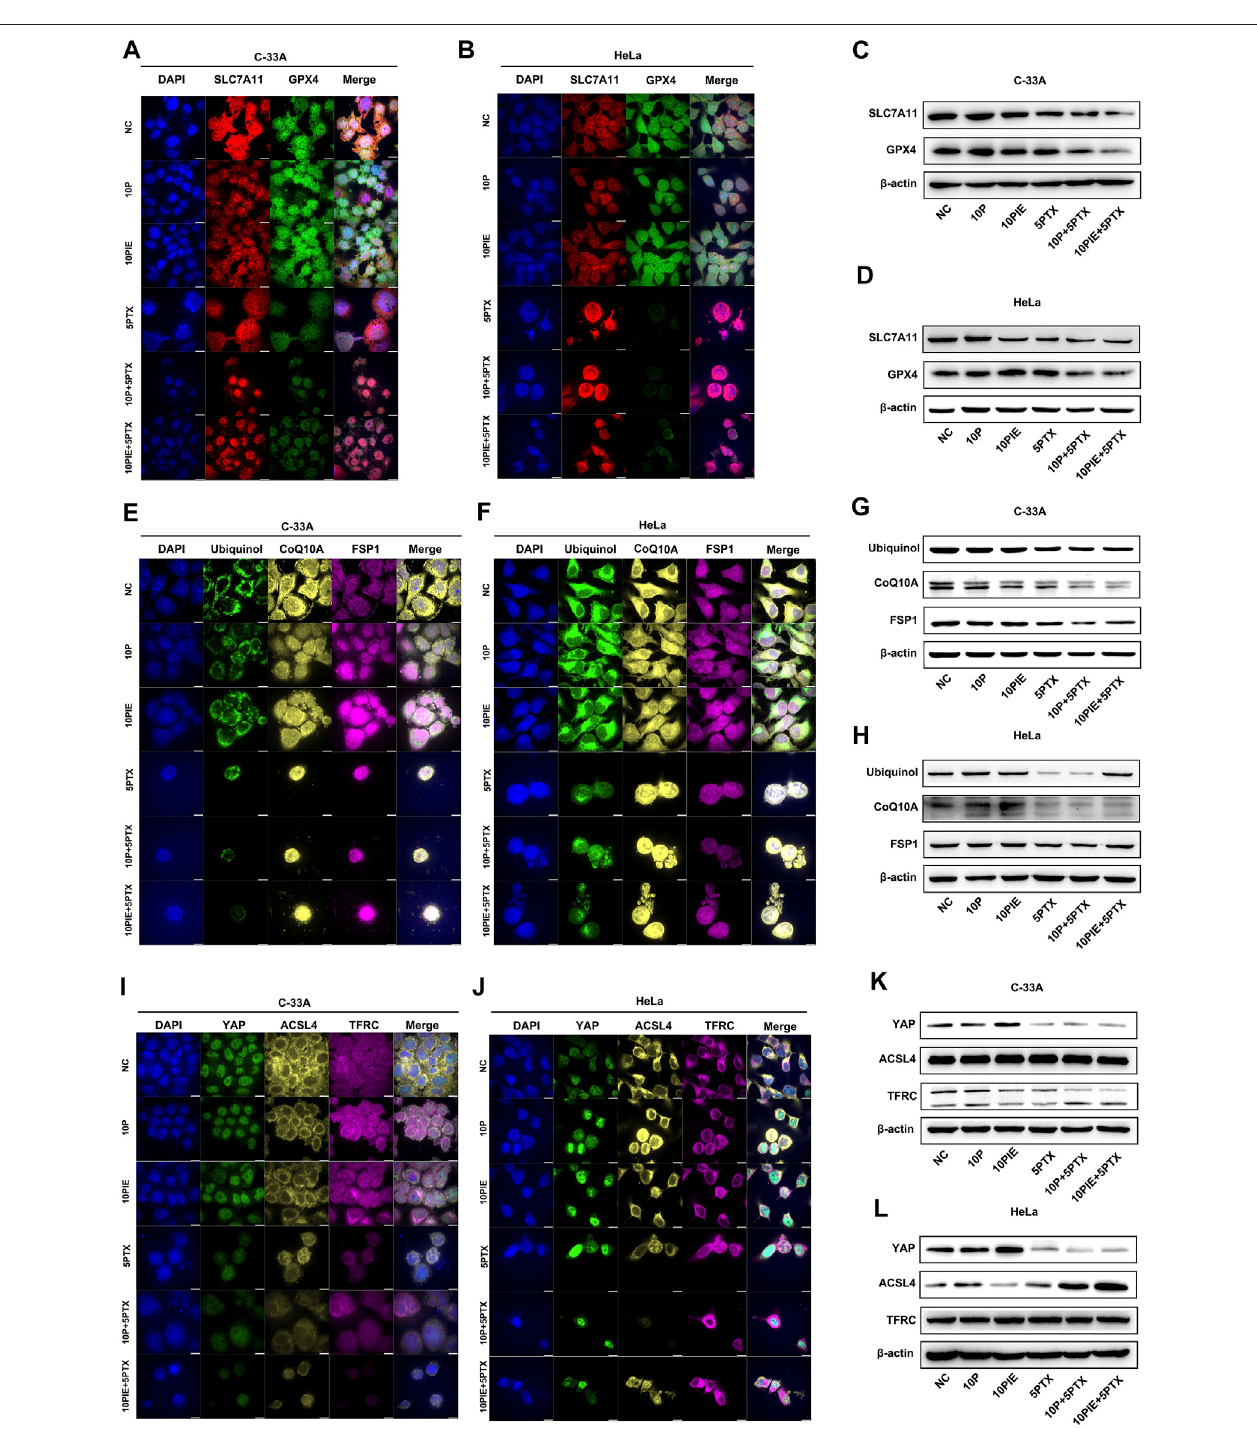
FIGURE 6 | Effects of propofol or PIE with or without paclitaxel on SLC7A11/GPX4, ubiquinol/CoQ10A/FSP1, and YAP/ACSL4/TFRC signaling pathways. The expression andsubcellularlocalizationofSLC7A11/GPX4 (A,B) ,ubiquinol/CoQ10A/FSP1 (E,F) ,andYAP/ACSL4/TFRC (I,J) inC-33AandHeLacellsweredetectedby mIHC.TheexpressionofSLC7A11/GPX4 (C,D) ,ubiquinol/CoQ10A/FSP1 (G,H) ,andYAP/ACSL4/TFRC (K,L) inC-33AandHeLacellsweredetermined byWB.Allthe bars indicated 10 µm.